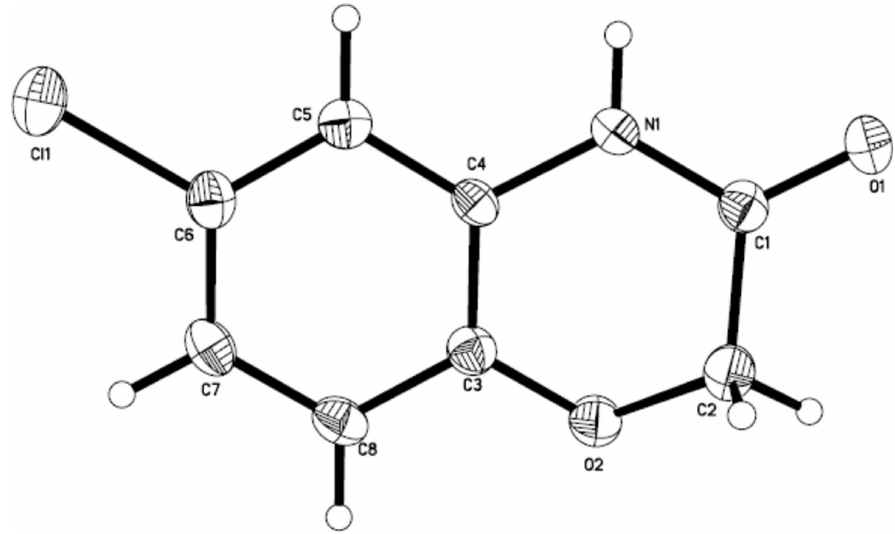
Figure 1 The molecular structure of the title compound, with displacement ellipsoids drawn at the 50% probability level. H atoms are shown as spheres of arbitrary